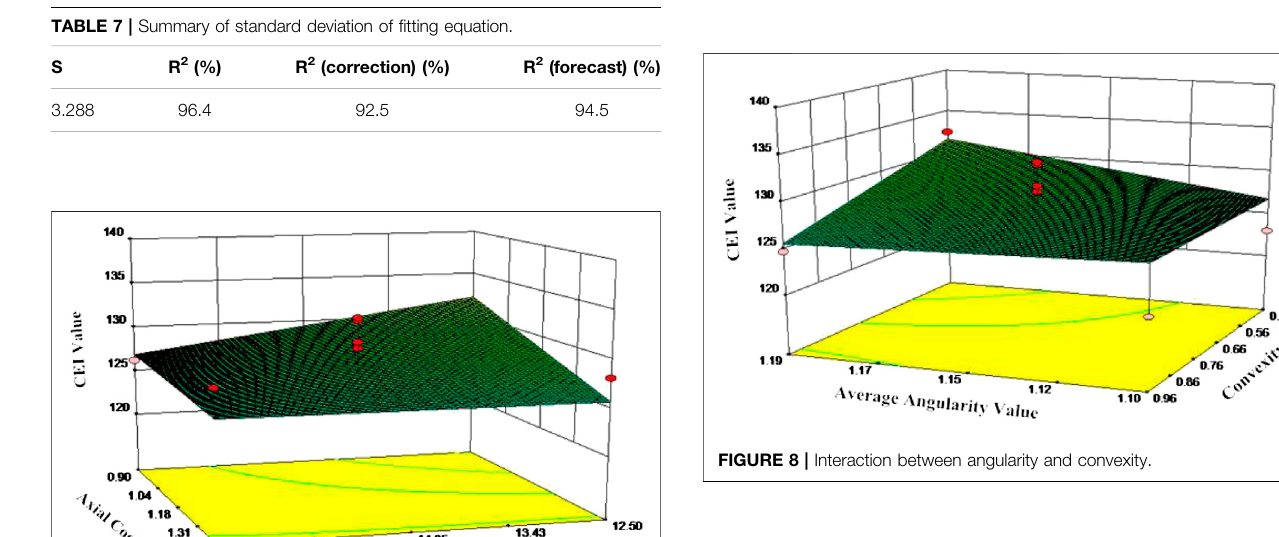
FIGURE 7 | Interaction between axial coef fi cient and crown.